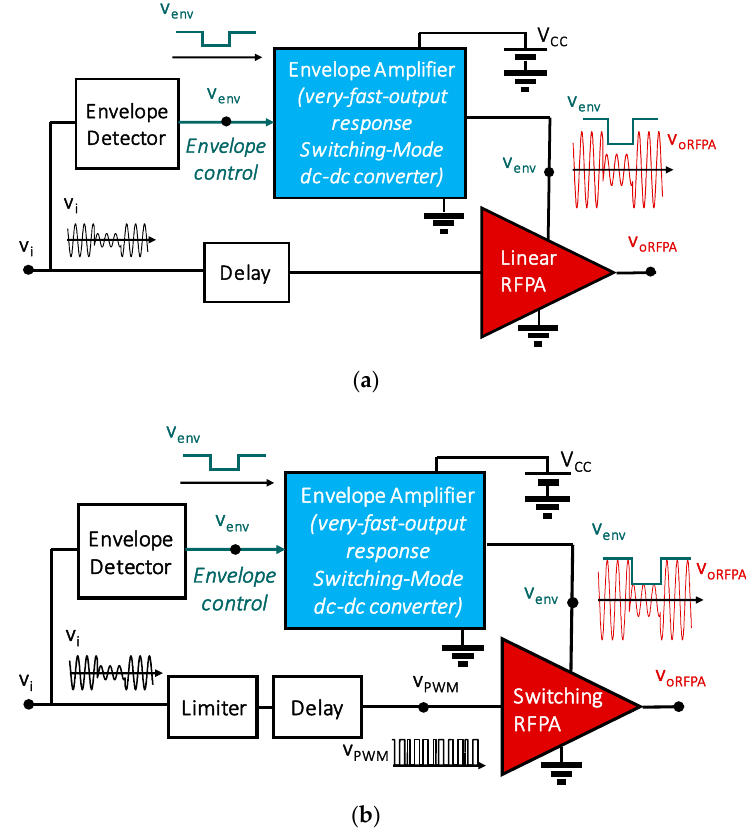
Figure 2. Conventional block diagram of techniques based on the use of Envelope Amplifiers (EA): ( a ) Envelope Tracking (ET) technique; ( b ) Envelope Elimination and Restauration (EER) technique.